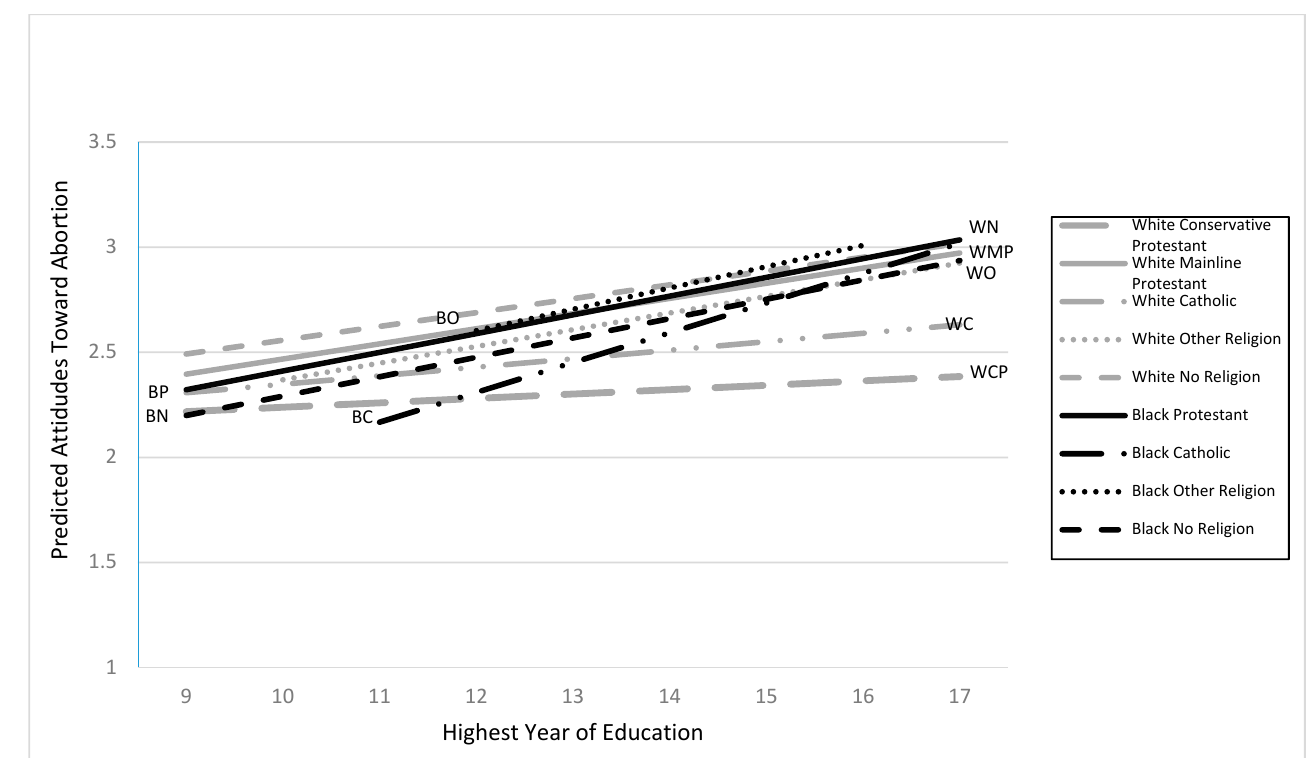
Figure A1. Views on abortion by race, religion, and education, Pew 2014 Religious Landscape Survey.